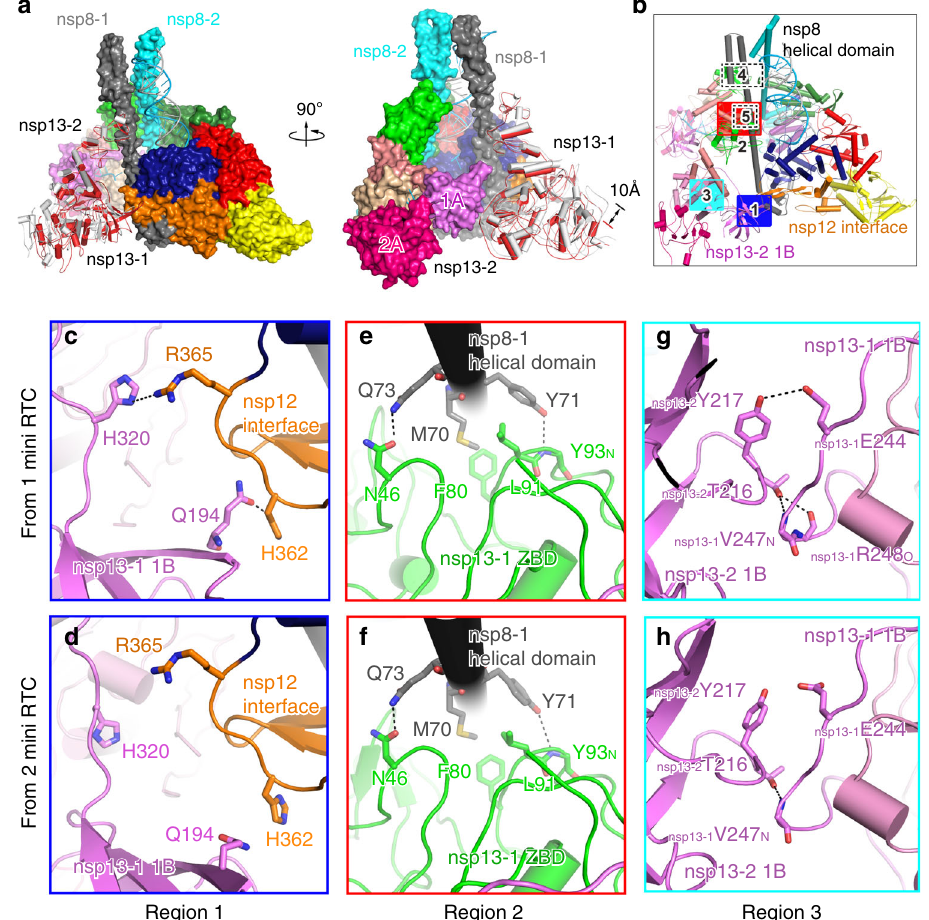
Fig. 3 Two orientations of nsp13-1. a Structural comparison of two mini RTCs in two perpendicular views. The structural parts with high similarity in two mini RTCs, including nsp7 – nsp8 – nsp12-RNA and nsp13-2, are covered by a molecular surface with the same color scheme in Fig. 1. Nsp13-1 molecules in form 1 and form 2 mini RTC are displayed as white and red cartoons. b The interaction regions of nsp13 molecules with other components of mini RTC or with each other. The structural details for region 1 ( c , d ), region 2 ( e , f ) and region 3 ( g , h ) are enlarged. Form 1 is in c , e , g ; form 2 is in d , f , h . Dashed lines denoted the interactions with a bond distance of less than 3.5